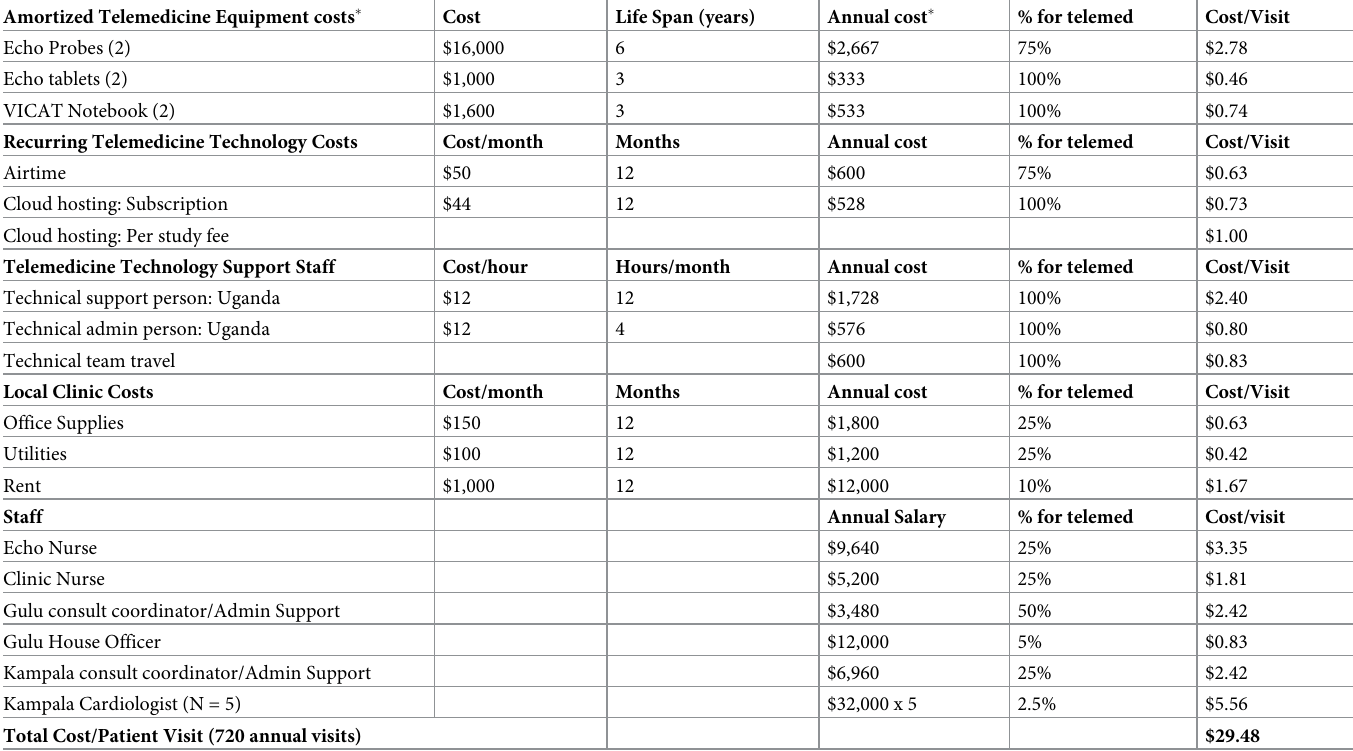
Table 5. Costs of telemedicine care delivery (based on 720 annual visits per